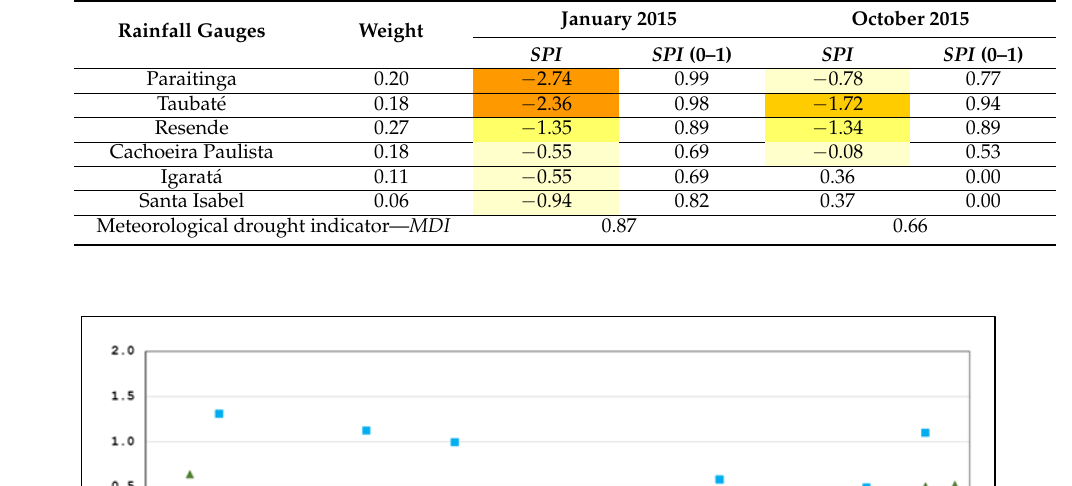
Table 8. Meteorological drought indicator (MDI ) application.